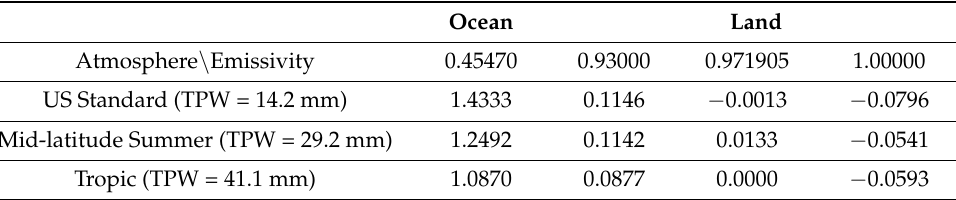
Table 1. ATMS channel 1 brightness temperature sensitivity to total precipitable water (K/mm) for the U.S. standard atmospheric profile [15], mid-latitude summer and tropical atmospheric profiles. The values in the second row are ocean surface emissivity, and three land surface emissivities (unitless). The values between the second and the fifth columns, and between the third and the fifth rows are the brightness temperature sensitivity on TPW in unit of K/mm. For example, for the case of U.S. standard atmosphere over ocean here, one millimeter water vapor increment will result in a 1.4333 K increase on the ATMS channel 1 brightness temperature. Ocean Land Atmosphere \ Emissivity 0.45470 0.93000 0.971905 1.00000 US Standard (TPW = 14.2 mm) 1.4333 0.1146 − 0.0013 − 0.0796 Mid-latitude Summer (TPW = 29.2 mm) 1.2492 0.1142 0.0133 − 0.0541 Tropic (TPW = 41.1 mm) 1.0870 0.0877 0.0000 −